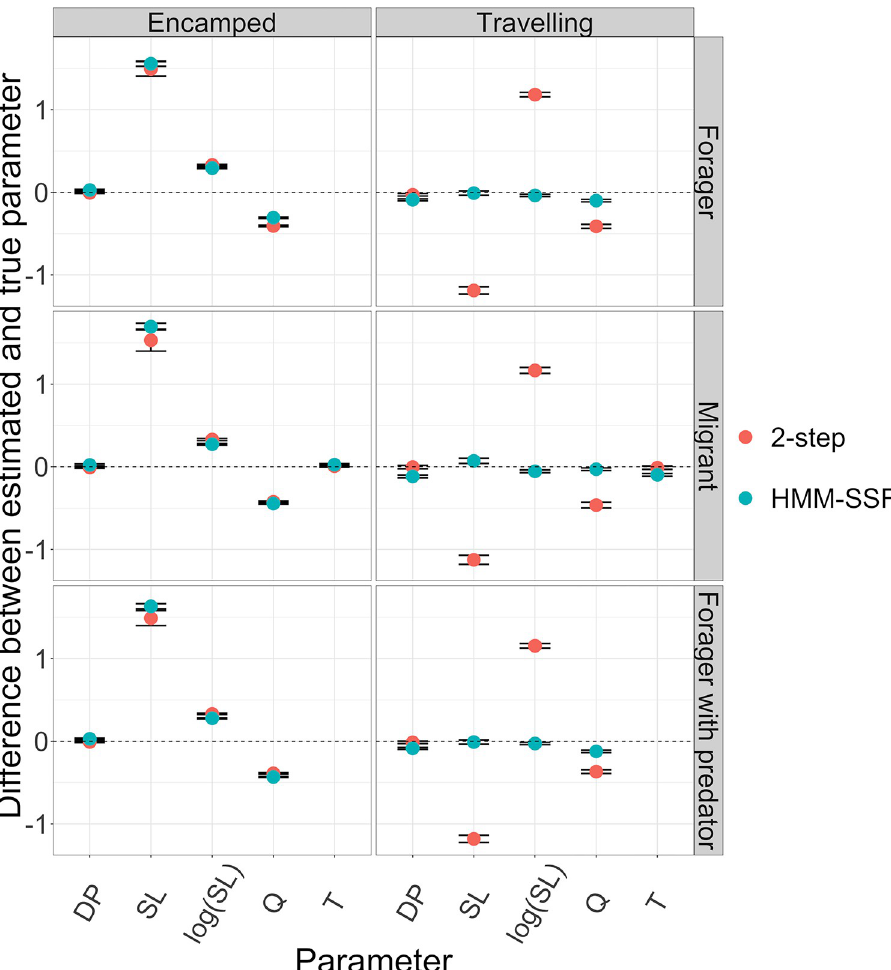
Fig 2. Difference between population level state-specific selection coefficients and their true parameters used to simulate individual’s trajectory, from state-specific step selection functions, in three ecological scenarios. Estimation from the HMM-SSF are represented in blue and estimation from the 2-step approach in red. 95% confidence interval of the difference is also shown with error bars. For each scenario, 500 trajectories were simulated from state-specific rules of movement and used to estimate population level state-specific selection coefficients. DP = directional persistence (cosine), SL = step length, log(SL) = natural logarithm of step length, Q = patch quality and T = target (see Eq